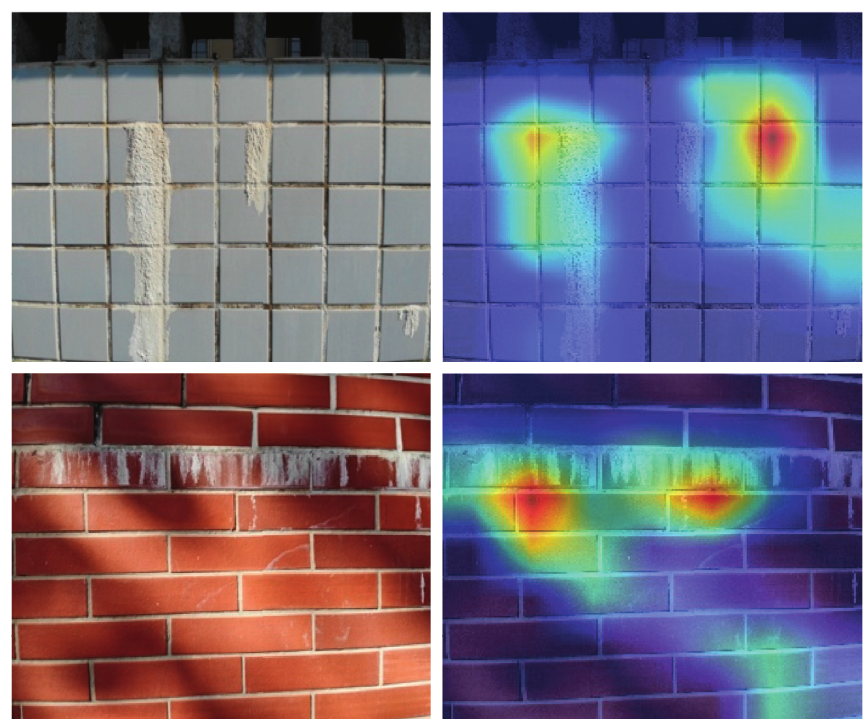
Figure 8: Efflorescence classified as spalling: comparison between original images and thermograms.